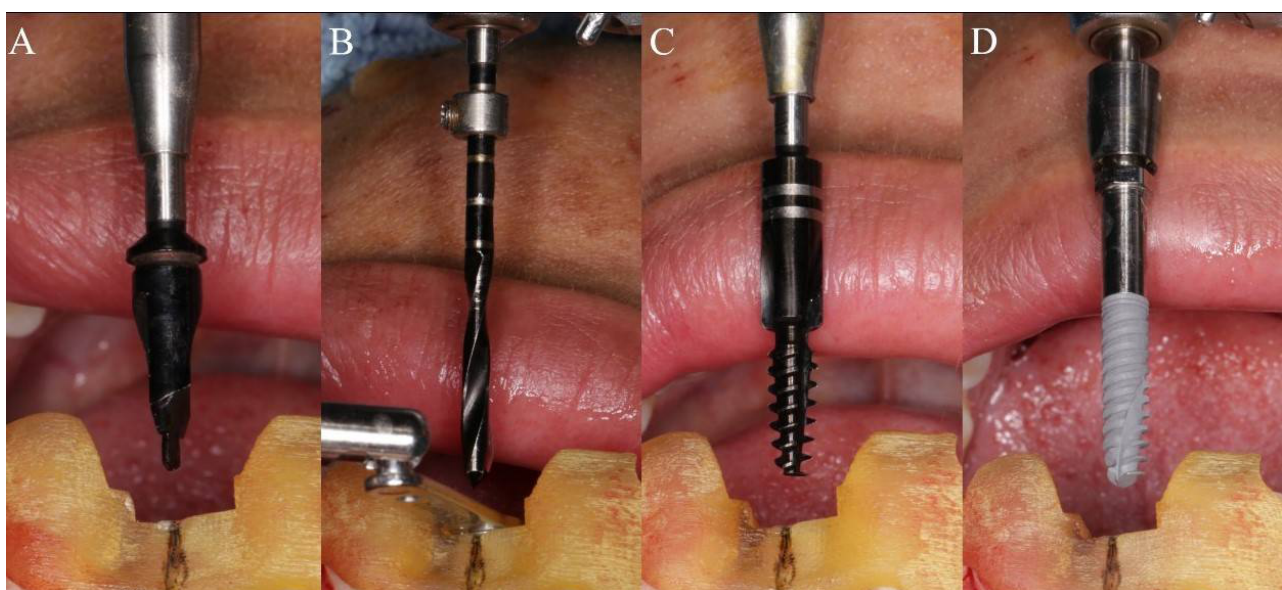
Figure 2. The sequence of the drill in conventional implantation protocol: ( A ) Conform the position with the initial guide drill under the guidance of the surgical template; ( B ) Preparation with sequential guided twist drills and corresponding guided drill guides under the guidance of the template; ( C ) Tapping with guided screw tap; ( D ) Implant insertion.